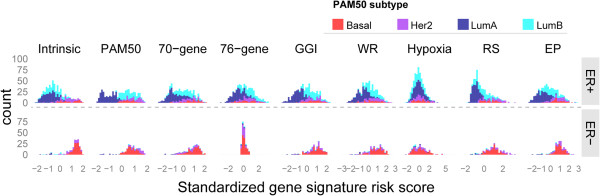
Gene-signature risk scores in relation to biological entities. Distributions of the subtypes (called by PAM50) stratified by ER status for individual gene signatures. Note that we used PAM50-classifications as proxy of proliferation. Luminal tumors dominate ER-positive group, while basal and Her2-enriched tumors drive the risk score higher in ER-negative group. In the ER-positive stratum, the risk assessment in most of the gene signatures is highly consistent with classification of luminal A and B tumors. Being more proliferative is known to distinguish luminal B tumors from luminal As. This indicates that the proliferation module, underlying many signatures, may drive the prognostication in ER-positive tumors.